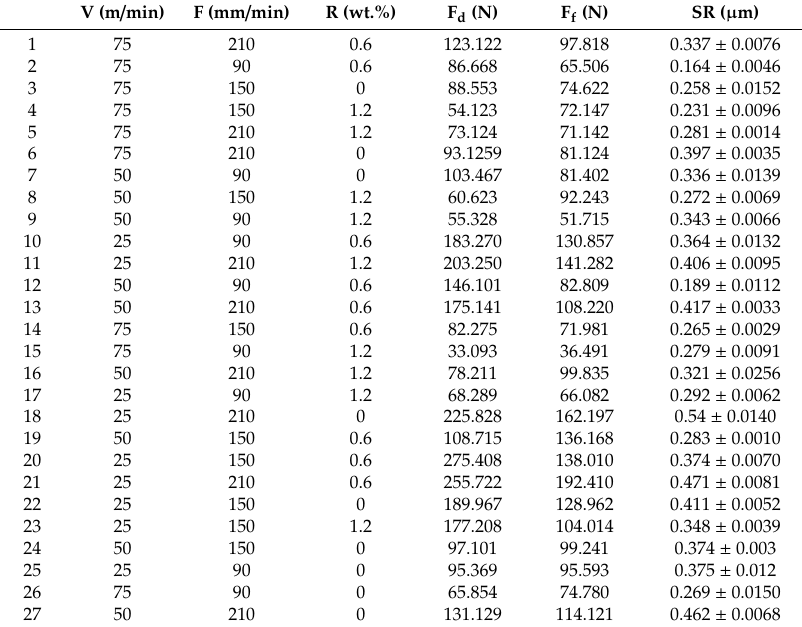
Table 5. Experimental design and corresponding results.